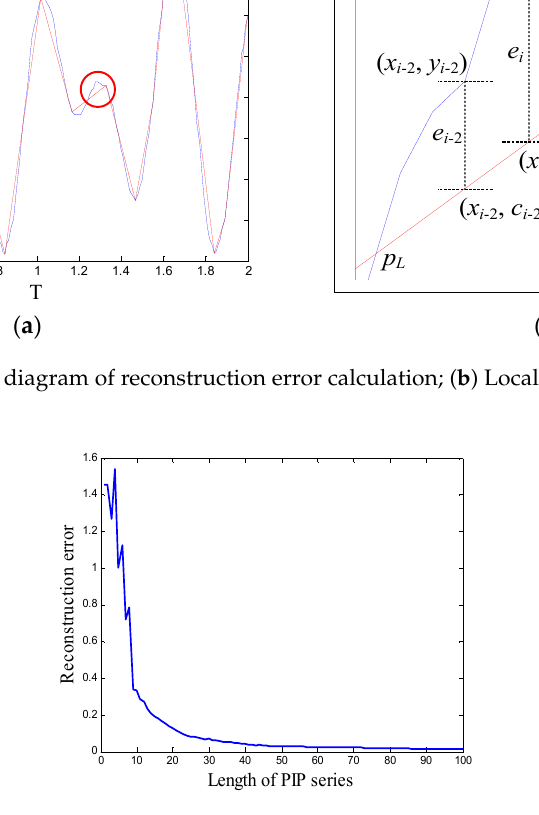
Figure 4. The relation between reconstruction error and the length of PIP series.